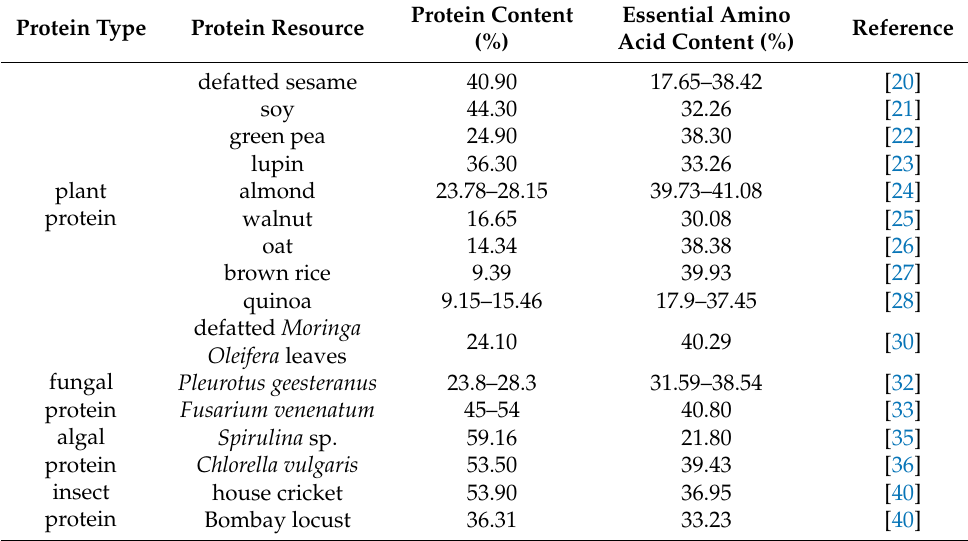
Table 1. Protein and essential amino content of some reported alternative protein